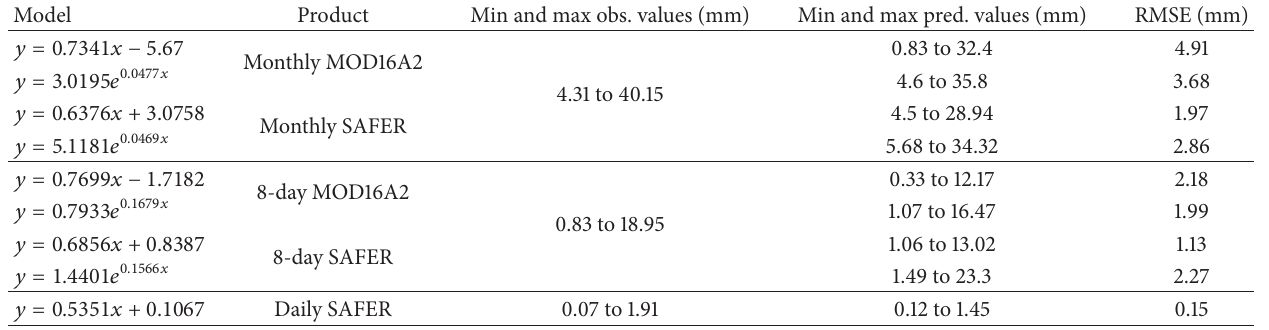
Table 2: Brief statistical summary and Root Mean Square Error (RMSE) of all nine evapotranspiration models.